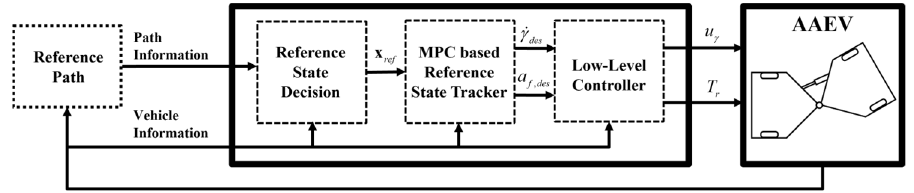
Figure 2. Overall architecture of the integrated control algorithm for the AAEV.